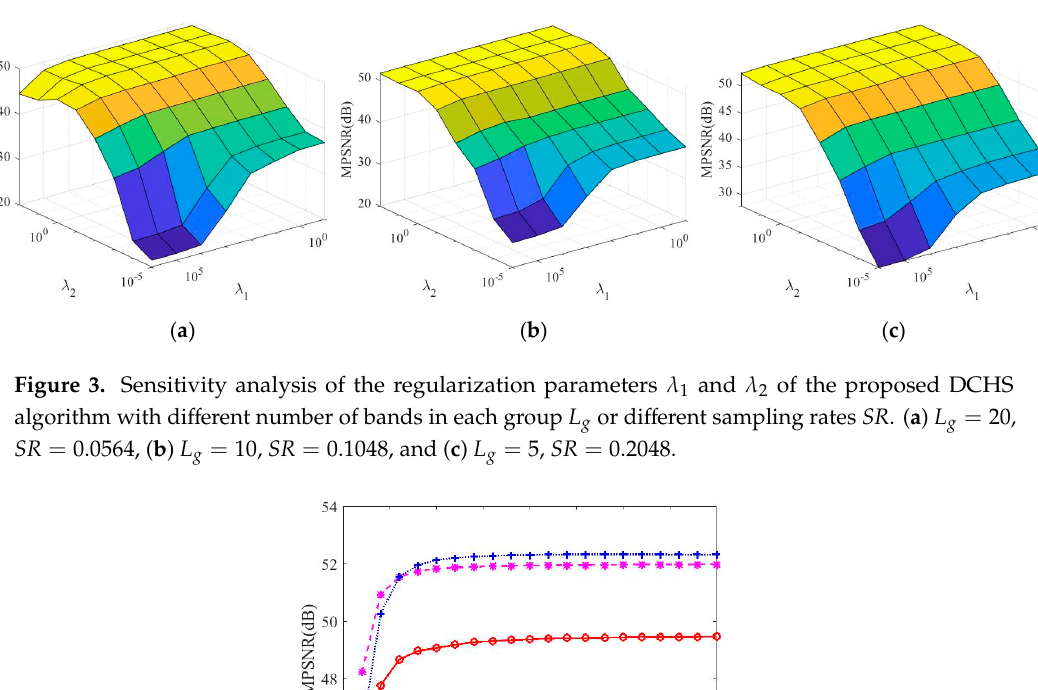
μ Figure 4. Sensitivity analysis of the parameter of the proposed DCHS algorithm with different Figure 4. Sensitivity analysis of the parameter µ of the proposed DCHS algorithm with di ff erent L . number of bands in each group L g number of bands in each group g